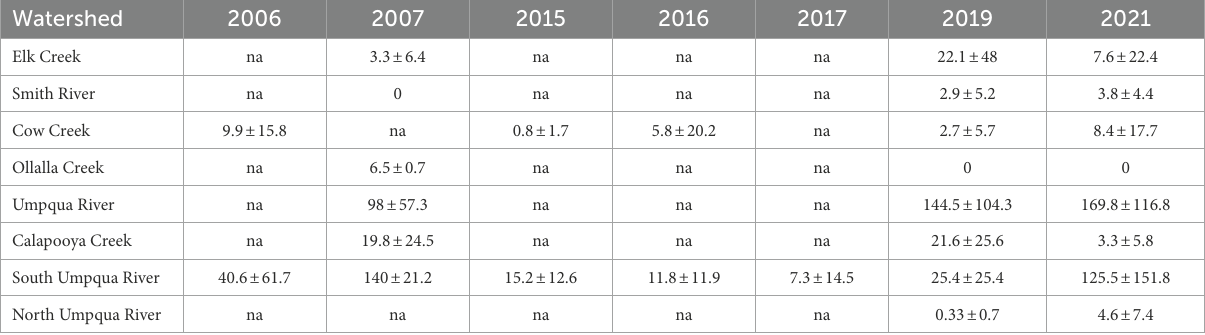
na indicates watershed was not surveyed in that